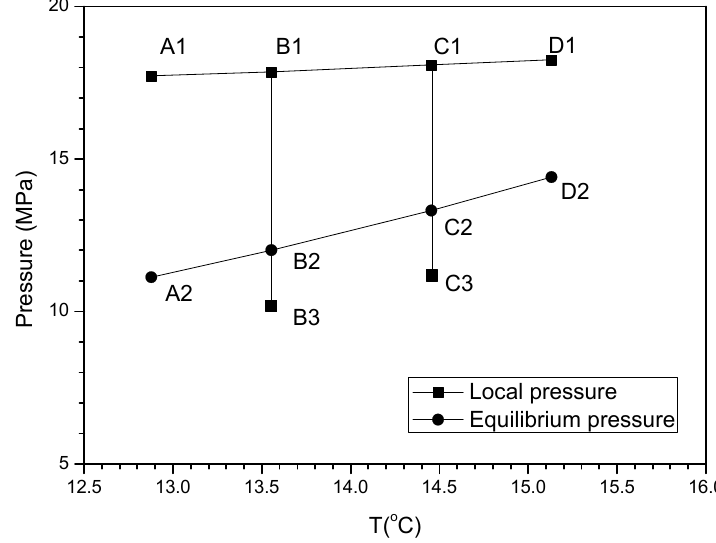
Figure 3. Profiles of the depressurization situation of the marine hydrate reservoir in the South China